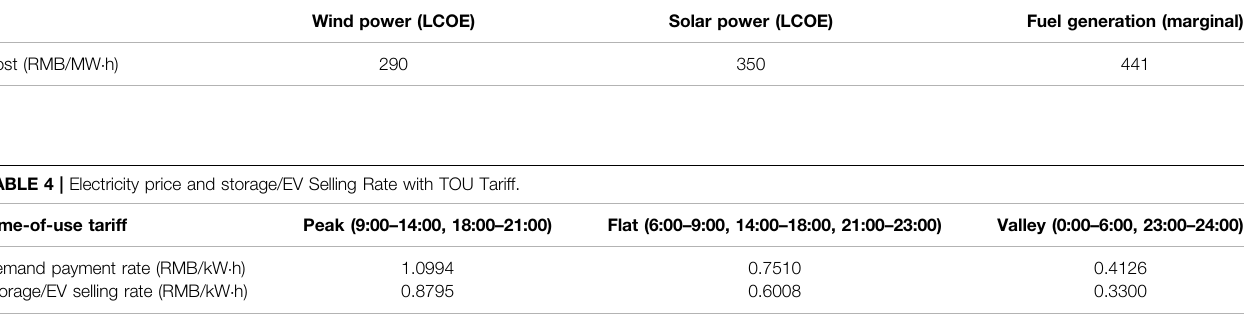
TABLE 3 | Generation marginal